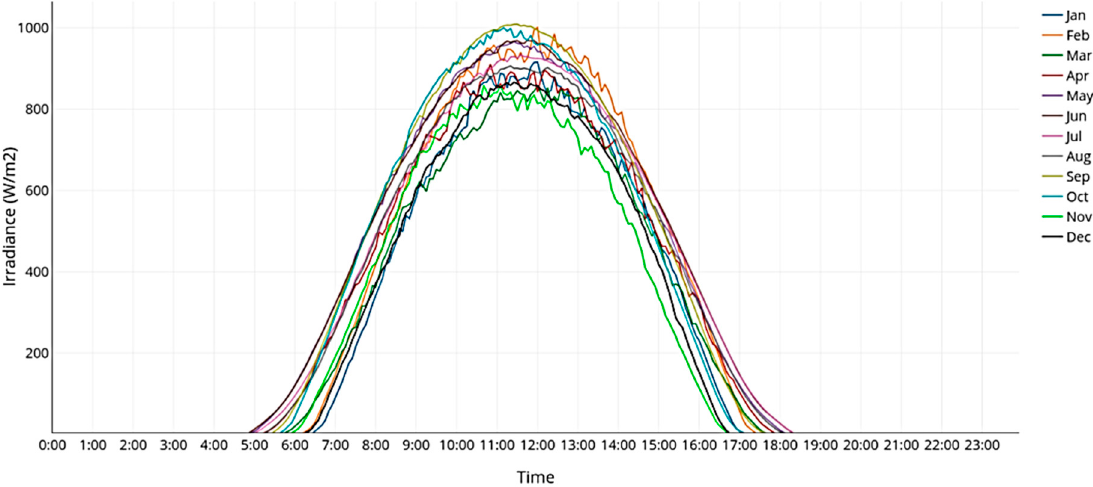
Figure 11. Monthly solar irradiance in Doha 2016.